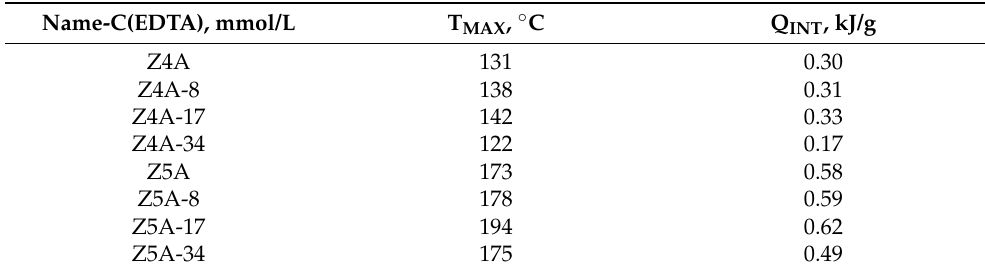
Table 3. Maximum desorption temperature (T MAX ) and integral heat of desorption (Q INT ) of the parent and EDTA dealuminated zeolite 4A and